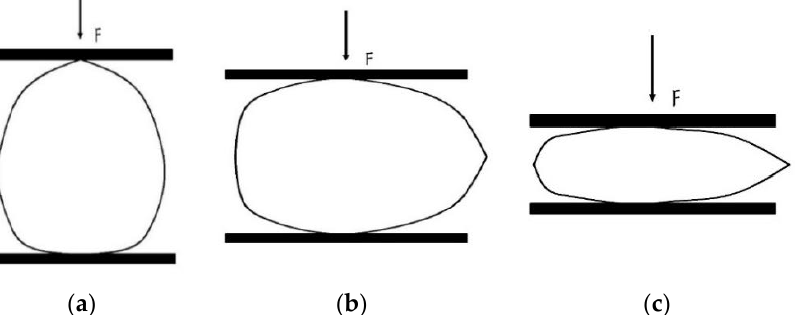
Figure 3. Schematic diagram of triaxial compression of sorghum seeds. ( a ) X -axis. ( b ) Y -axis. ( c ) Z -axis.